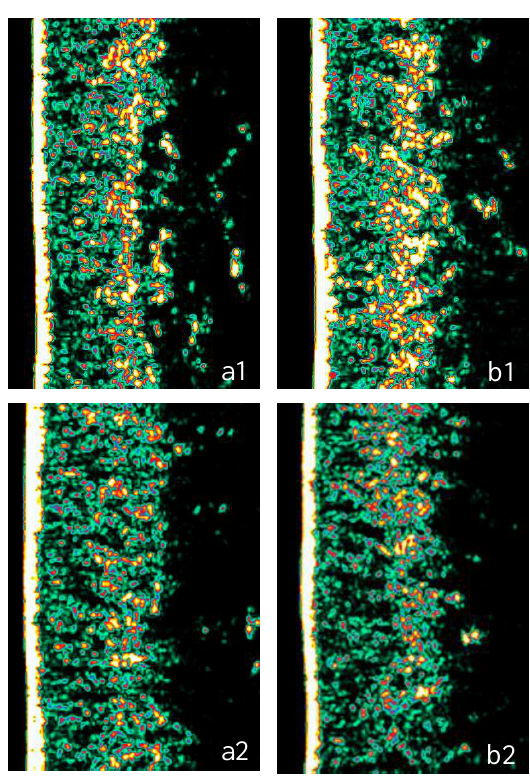
Figure 3. Examples of ultrasound images of the skin before and after 12 weeks of supplementation for a subject from the test group ( a1 and b1 ) and from the placebo group ( a2 and b2 ). In the ultrasound image, the white line to the left represents the epidermis with a water film, to the right followed by dermis, characterized by varying intensities, and subcutis by low-intensity areas due to a homogenous composition. From images a1 and b1, an increase in dermis echogenicity is visible, indicating an improvement in dermal density throughout the study, while slight deterioration can be observed from images ( a2 ) and ( b2 ). Echogenicity colour scale: white > yellow > red > green > black.